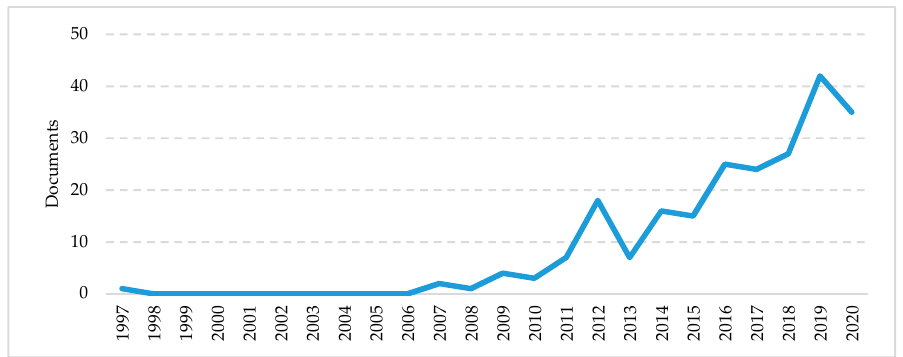
Figure 8. Documents published on sustainability and open innovation between 1997 and 2020.